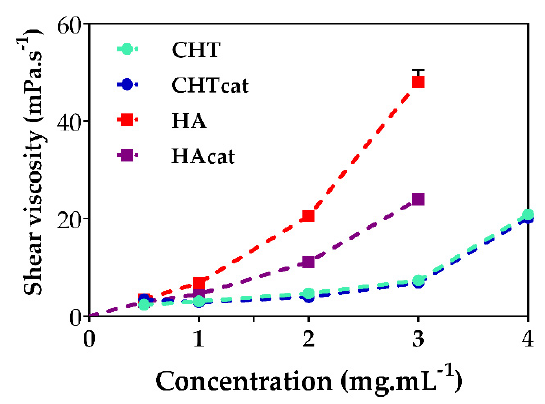
Figure A9. Scheme for synthesis of HAcat, describing the conjugation strategy of hyaluronic acid (HA) to dopamine (DN), using EDC chemistry.